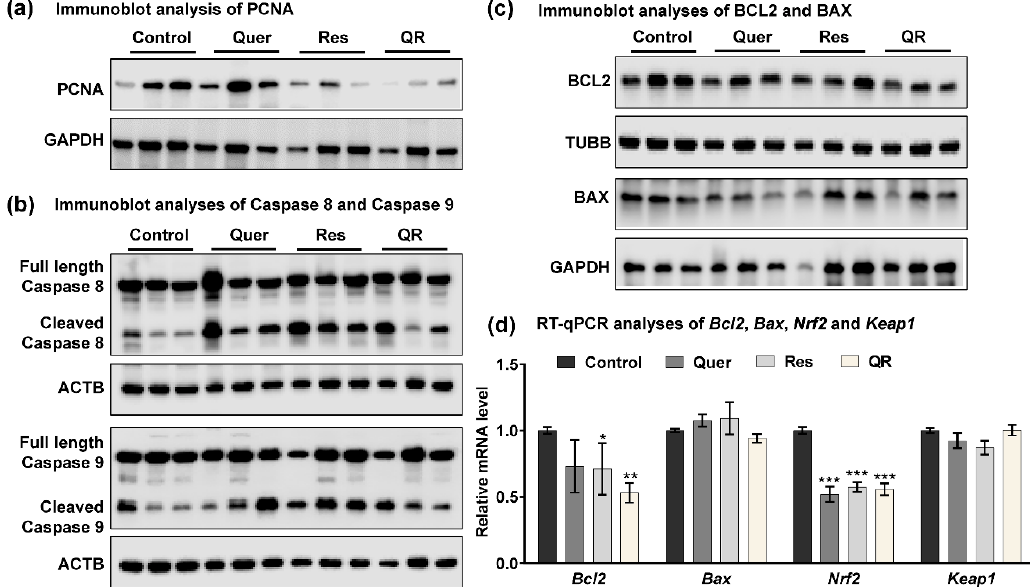
Figure 3. Quercetin–resveratrol supplementation induces apoptosis in prostate tumors. ( a ) Immunoblot analysis of PCNA protein. GAPDH was used as a loading control. ( b ) Immunoblot analyses of full length and cleaved caspases-8 and -9 proteins in TRAMP tumor tissues. β -actin (ACTB) was used as a loading control. ( c ) Immunoblot analyses of BCL2 and BAX proteins. β -tubulin (TUBB) and GAPDH were used as loading controls. ( d ) RT-qPCR analyses of Bcl2 , Bax , Nrf2 , and Keap1 mRNA levels in TRAMP tumor tissues. Data are represented as mean ± SEM. A one-way ANOVA with Tukey’s multiple comparison test was performed (* p <0.05, ** p <0.01, *** p <0.001).